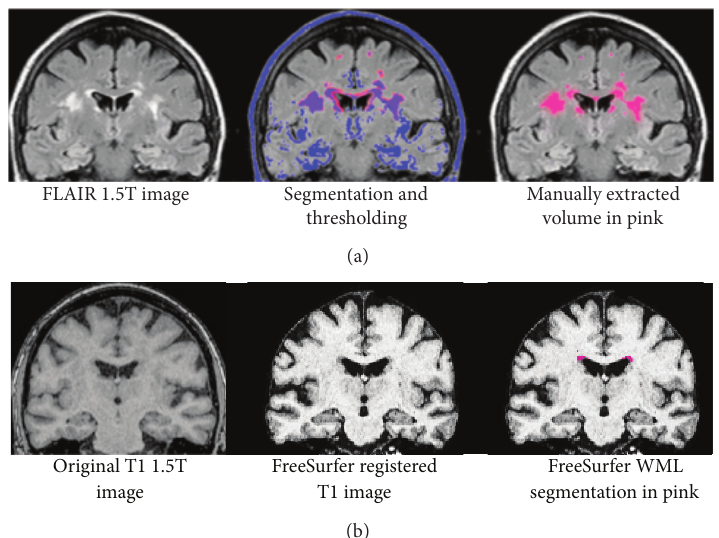
F 5: 1.5T MR images from a patient with severe-burden WML showing the differences in scan sequence and WML detection between manual MRIcron volumetry (a) and automatic FreeSurfer volumetry